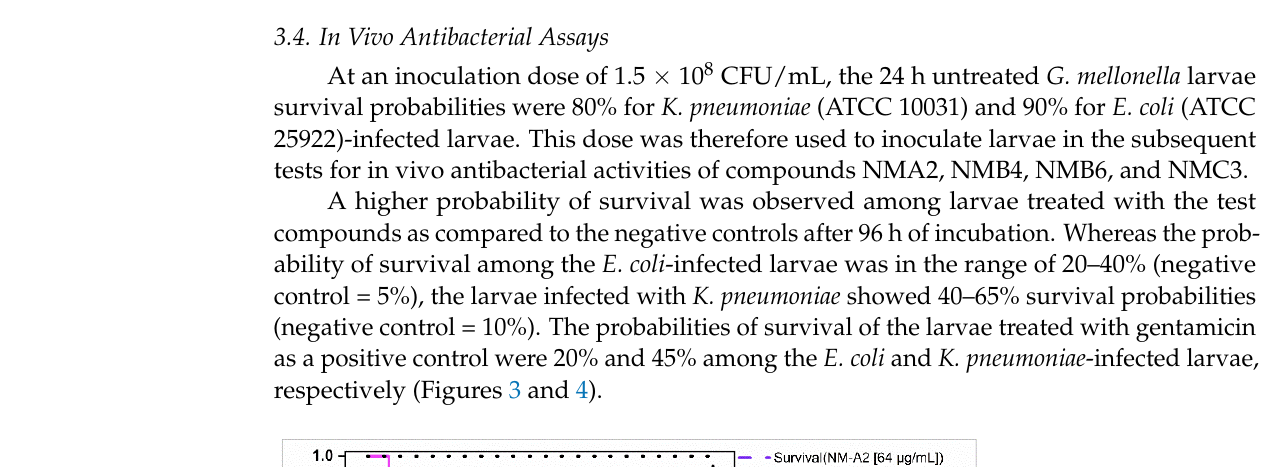
A higher probability of survival was observed among larvae treated with the test compounds as compared to the negative controls after 96 h of incubation. Whereas the prob- ability of survival among the E. coli -infected larvae was in the range of 20–40% (negative control = 5%), the larvae infected with K. pneumoniae showed 40–65% survival probabilities (negative control = 10%). The probabilities of survival of the larvae treated with gentamicin as a positive control were 20% and 45% among the E. coli and K. pneumoniae -infected larvae, respectively (Figures 3 and 4).